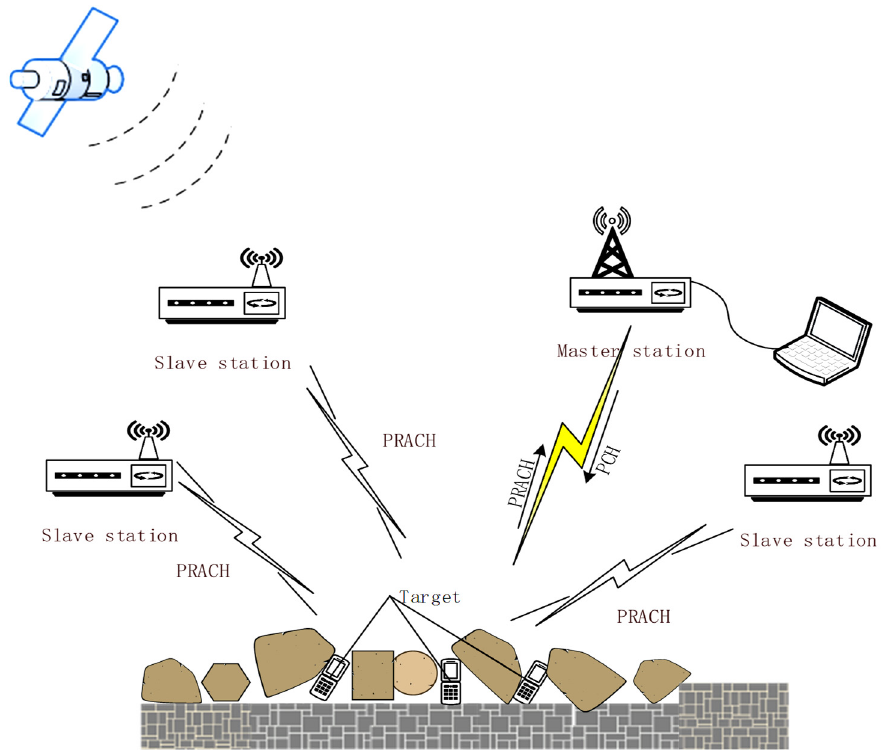
Figure 1. Semi-passive positioning system in ruin environment composed of 1 master base station and n slave base stations.